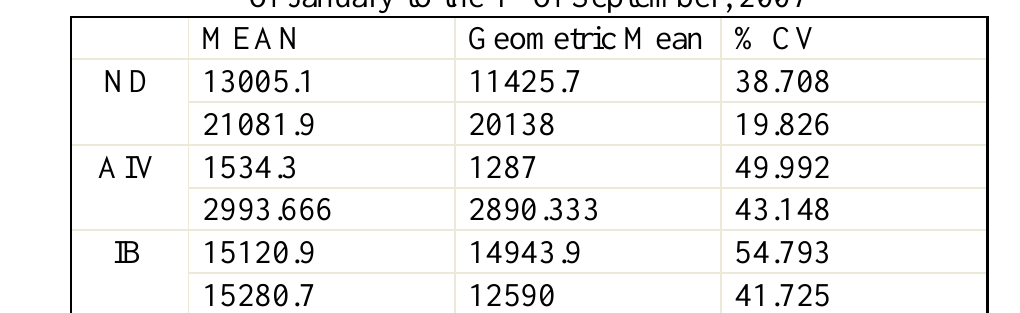
Table (4): ELISA results of ND, AIV and IB antibody titres o the from the1 st